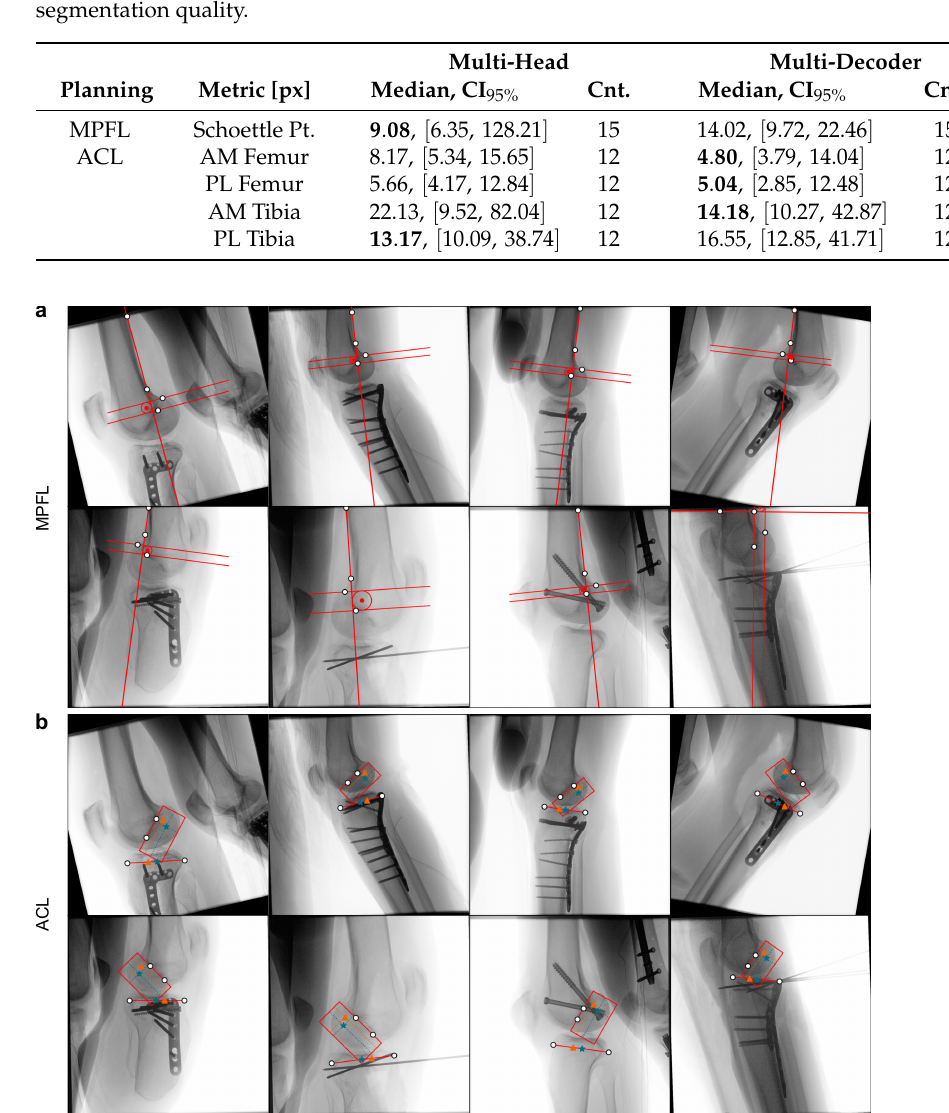
Table 3. Numerical planning results on intra-operative test data. Each metric value is reported w.r.t. the original resolution of [ H:976 × W:976 ] px. The results of the best network variant for each